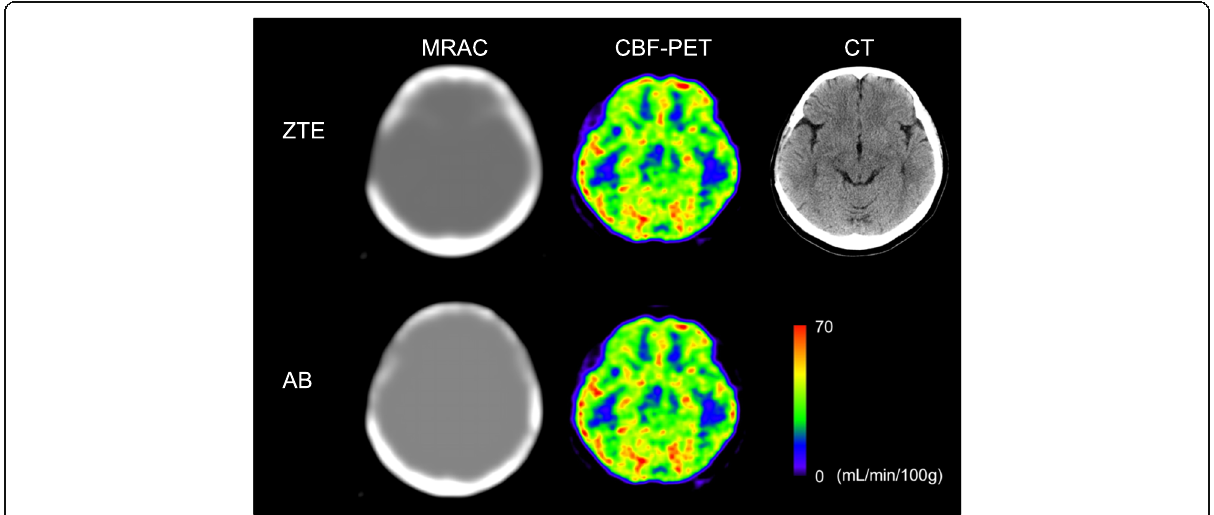
Fig. 7 ZTA-, AB-MRAC, and CBF images at the same slice level from a patient who underwent neurosurgical treatment. Top row shows the ZTE- MRAC, CBF, and CT at the corresponding slice level (right). The defect of the right temporal bone is clearly delineated by the ZTE-MRAC (left). The bottom row shows the images from the AB-MRAC method (left), which generated the right temporal bone. CBF images from the two methods show that CBF values in the right temporal lobe were very close (middle column). This PET scan was not included in the